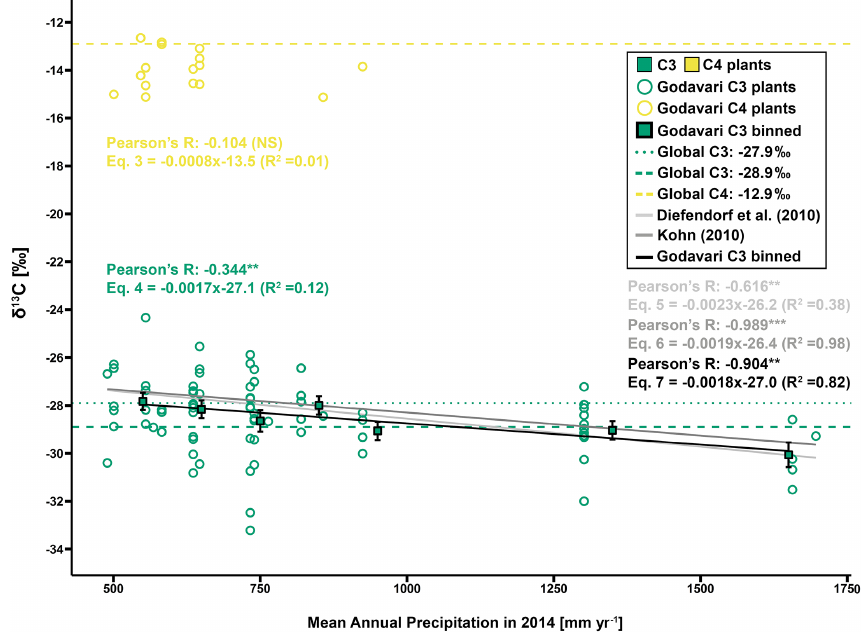
Figure 4. Regression analysis of δ 13 C values against MAP (2014, previous growing season) for C 3 and C 4 plants in the Godavari basin and estimates based on global C 3 vegetation models by Diefendorf et al. (2010) and Kohn (2010). For Godavari C 3 plants, δ 13 C values are also binned per MAP of 100mmyr − 1 , and the mean ± standard error (SE; whiskers) is presented. The bin of 500–600mmyr − 1 includes two samples with a MAP of 489mm. The solid lines denote the linear fit for the Diefendorf et al. (2010), Kohn (2010) and C 3 binned correlation. Pearson’s R , equation and R 2 are given for each correlation. Compilation-based δ 13 C values of vegetation sampled around the world are given for C 4 ( − 12 . 9‰) (yellow dashed) and C 3 plants (see Table 1). The latter is represented by a commonly quoted δ 13 C value of − 27 . 9‰ (dark green, dotted) that is biased toward dry ecosystems according to Kohn (2010) and a δ 13 C value established by Kohn (2010) of − 28 . 9‰ (dark green, dashed) that includes more equatorial and mid-latitude C 3 biomass. The level of significance is as follows: NS for not significant, ∗ for p ≤ 0 . 05, ∗∗ for p ≤ 0 . 01 and ∗∗∗ for p ≤ 0 .